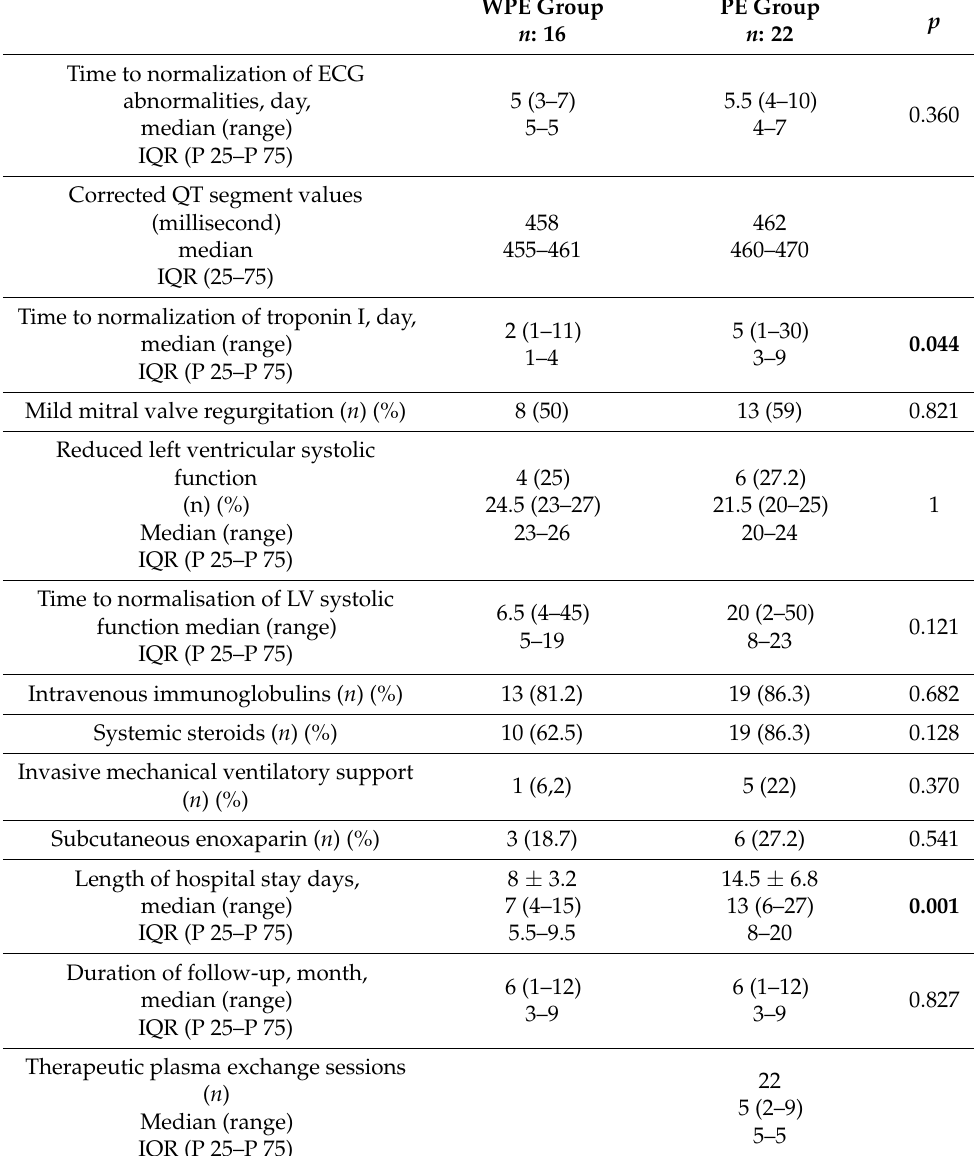
Table 2. Comparison of the group benefitting from plasma exchange (PE group) versus the group not benefitting from it (WPE group) in terms of normalization of pathologic values, treatment modalities, hospitalization duration, and